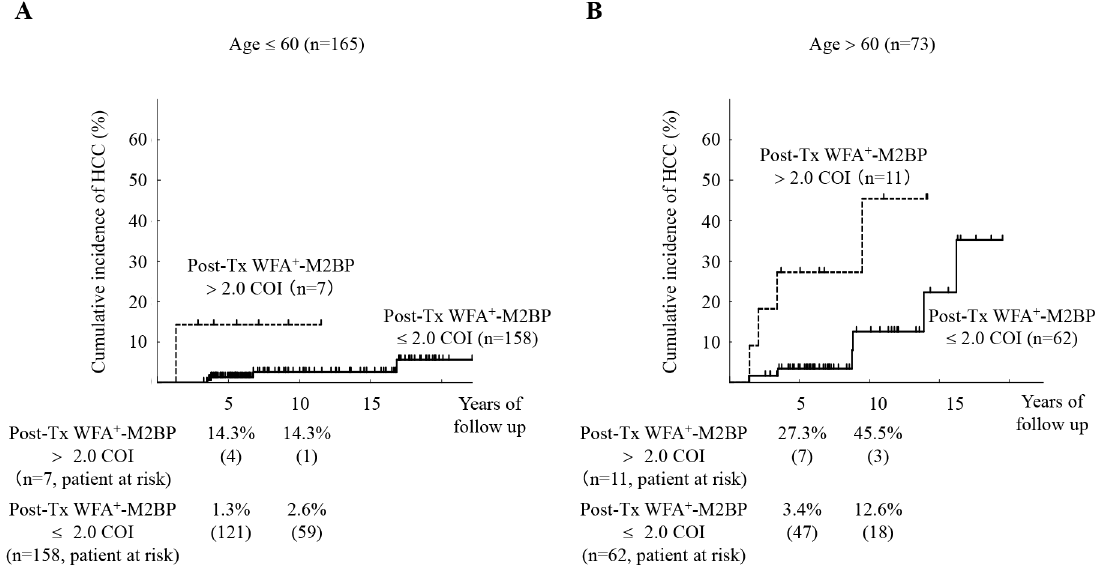
Fig 2. Cumulative incidence of hepatocellular carcinoma (HCC) according to post-treatment WFA + -M2BP values, stratified by age. (A): Age (cid:5) 60 years (n = 165). (B): Age > 60 years (n = 73). Cumulative incidences of HCC according to post-treatment WFA + -M2BP values were analyzed using the Kaplan-Meier method. The black solid and dotted lines indicate the stratified post-treatment WFA + -M2BP values with a COI (cid:5) 2.0 and a COI > 2.0, respectively. The incidence rate differed significantly between the two groups ( P < 0.0001 by the log-rank test). The numbers of patients at risk at each time point are shown below the graphs.